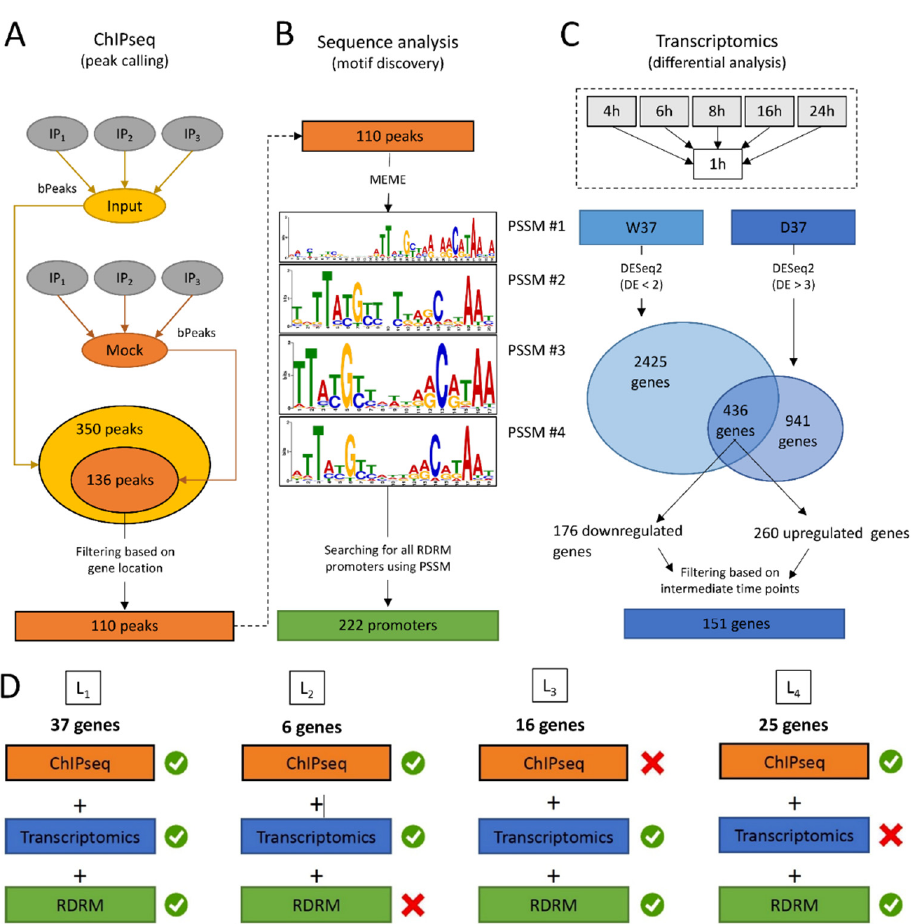
Figure 1. Overview of the computational strategy used to integrate omics data and identified candidate genes for inclusion in the DdrO regulon. ( A ). ChIP-seq analyses, i.e., defining the genomic regions for which interactions between DNA and the DdrO protein were observed. The three IP replicates were compared to the Input and Mock controls. Peaks identified in both comparisons were retained. An additional filter was applied to focus on only the peaks located in intergenic regions. ( B ). Sequences of the peaks identified in ( A ) were used to search for over-represented DNA motifs, applying the MEME program. Four position specific scoring matrixes (PSSMs) were retained, because of their redundancies. PSSM were used as inputs for the FIMO program, scanning sequences between − 500 and +100 of all annotated CDS. Positive matches were retained and are referred to as “RDRM promoters”. ( C ). RNA-seq data was used to identify differentially expressed genes, comparing each time point (4, 6, 8, 16, and 24 h) to the first (1 h). In the W37 strain, genes identified as differentially expressed in less than two comparisons were selected (DE < 2), whereas in the D37 strain, genes identified as differentially expressed in more than three comparisons were selected (DE > 3). Common genes from the two lists were retained and an additional filter was applied to focus further analyses on only these genes which exhibited differential expression (up- or downregulation) at intermediate times, i.e., 6, 8, and 16 h. ( D ). Results obtained in ( A – C ) were integrated to define four lists in the DdrO regulon. The first list is comprised of genes for which (i) a peak was detected upstream of the gene location (ChIP-seq results), (ii) specific differential expression was observed in the D37 strain (transcriptome results), and (iii) an RDRM motif was found in the gene’s promoter region (sequence analysis). Other lists (L2-L3-L4) matched with only two criteria (green tick mark). These genes are worth considering as potential targets for DdrO.